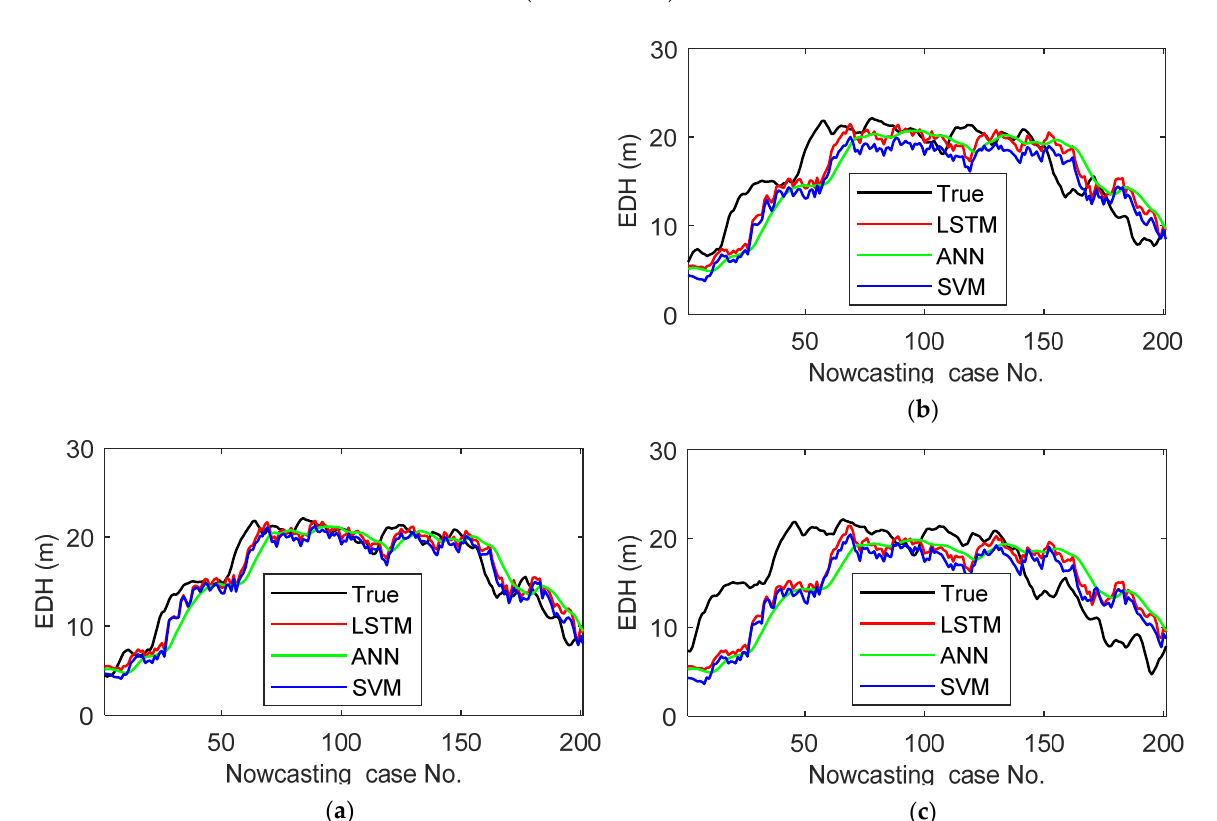
Figure 9. Comparison of the nowcasted evaporation duct heights. ( a ) 30-min forecast; ( b ) 60-min forecast; ( c ) 120-min forecast. Table 2. Comparison of nowcast results based on different models.